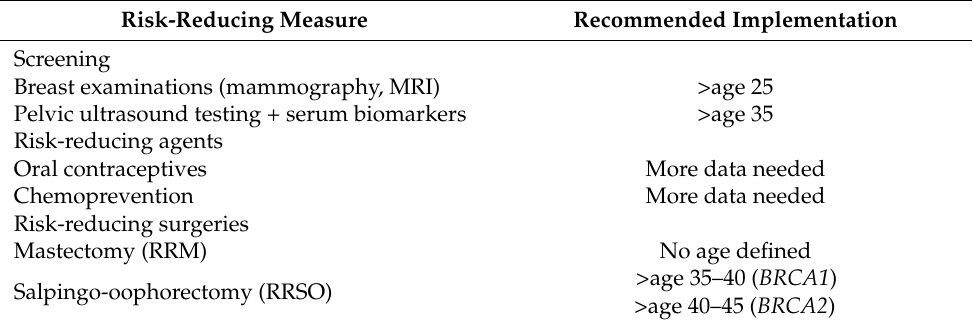
Table 2. Risk-reducing measures recommended by clinical guidelines for BRCA mutation